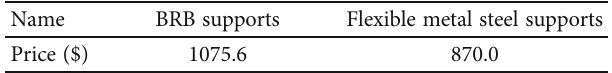
Table 5: Di ff erent damper price